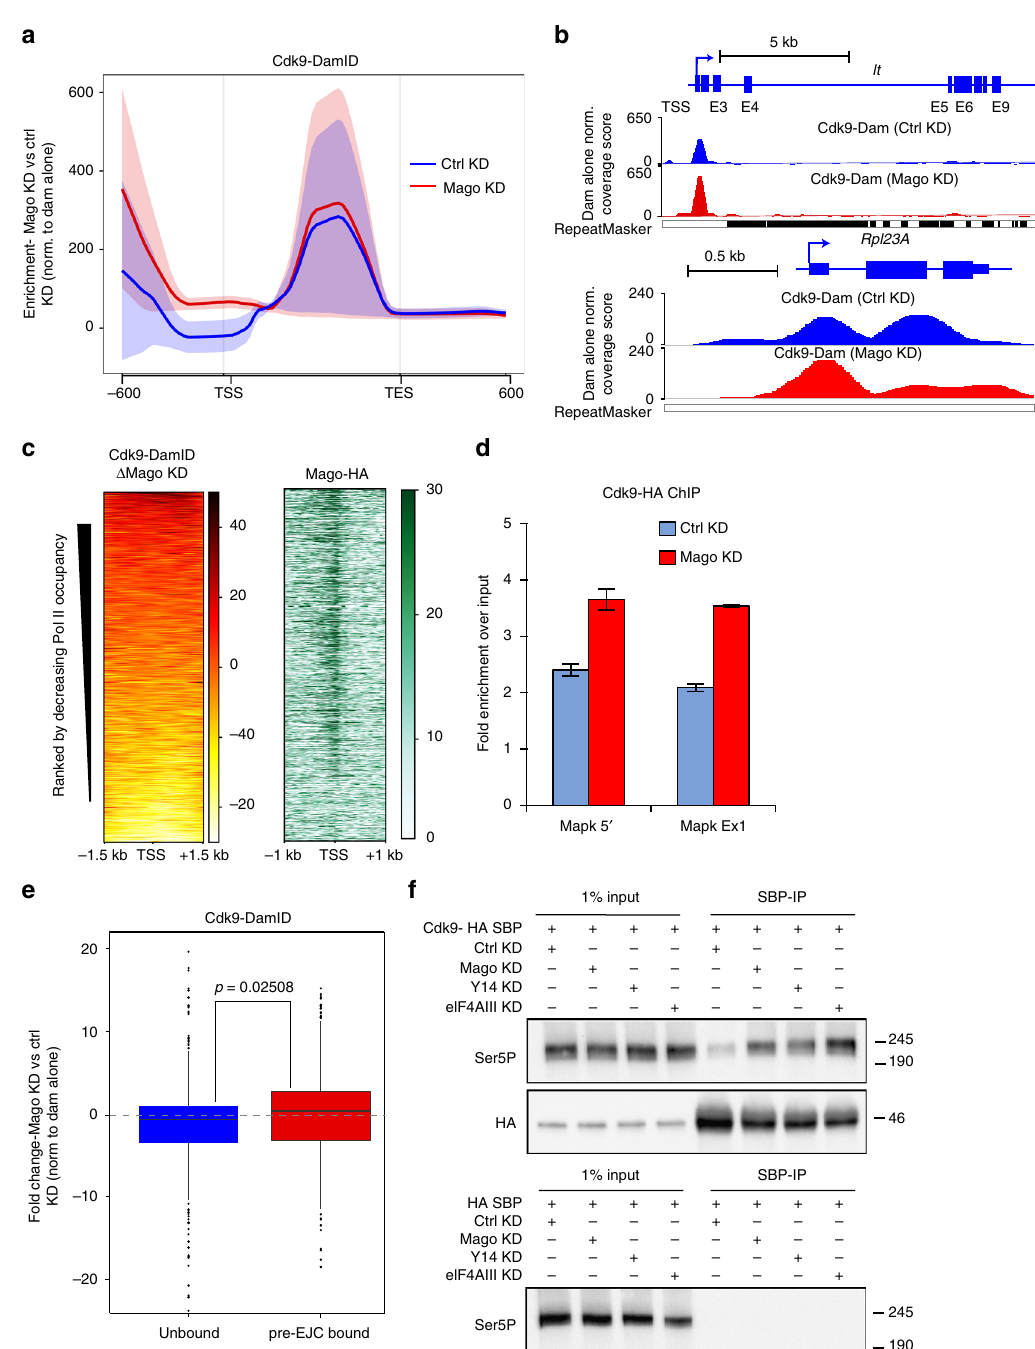
Fig. 5 Loss of pre-EJC core components results in increased Cdk9 binding to Pol II. a Metagene pro fi les of Cdk9-DamID in control and Mago knockdown cells as averaged enrichment over input from two independent biological replicates with standard error of the mean for all the expressed genes. Fold enrichment represented on Y -axis was calculated against Dam alone control in respective conditions (using damidseq_pipeline), while X -axis depicts scaled genomic coordinates. b Genome browser view of Dam alone normalized and averaged tracks of Cdk9-DamID for light and Rpl23A . c Heatmaps of changes in normalized Cdk9-DamID enrichment in Mago depleted S2R + cells compared to control, centered at the TSS in a ±1.5 Kb window. Rows indicate all the genes bound by Pol II and are sorted by decreasing Pol II occupancy, and the color labels to the right indicate the level of enrichment. Heatmap of Mago-HA centered at the TSS ( − 1 kb to + 1 kb) is also shown. d ChIP-qPCR analysis of Cdk9-HA occupancies at indicated MAPK locus. Error bars indicate the standard deviation of three biological replicates. e Changes in Cdk9 occupancy at the TSS (250 bp upstream and downstream of TSS) after control and Mago knockdowns, calculated from Cdk9-DamID experiment, after normalizing to the Dam alone control. The changes were separated according to pre- EJC binding and a two-sample t -test was performed. f Co-immunoprecipitation experiments from S2R + cells extracts expressing either HA-SBP-Cdk9 or HA-SBP alone, revealed with Pol II Ser5P antibody. Immunoprecipitations were performed from control cells or cells depleted for pre-EJC core components (Mago, Y14, and elF4AIII). Shown also is the western blot against HA tag to assess the ef fi ciency of the pull-down of HA-SBP-Cdk9 in each